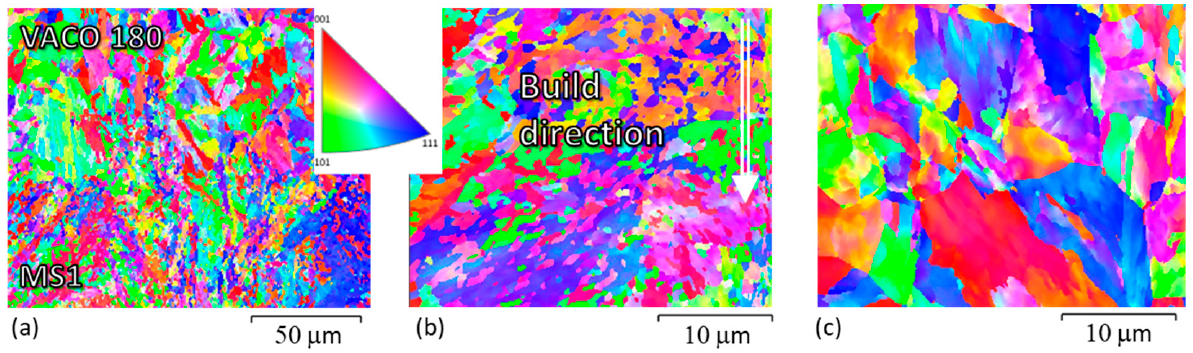
Figure 11. EBSD (IPF–Z direction) of a hybrid part annealed at 820 ◦ C: ( a ) VACO 180-MS1 interface; ( b ) additively manufactured MS1; ( c ) conventionally prepared VACO 180 steel.